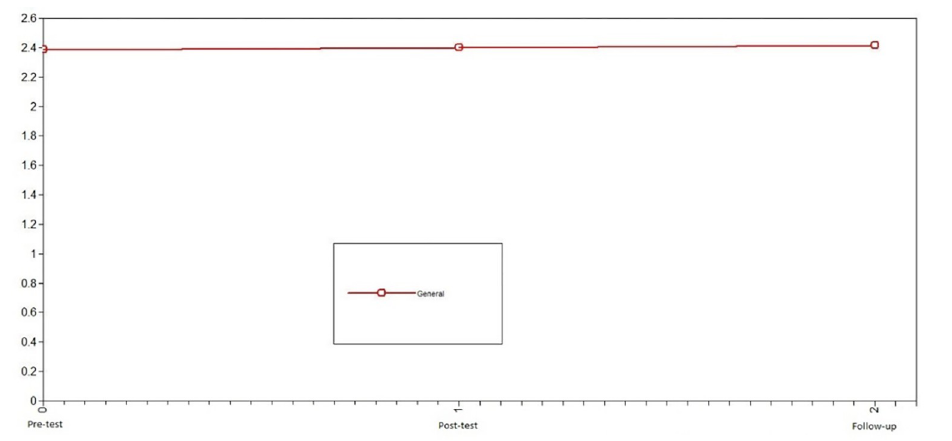
Fig 3. Latent growth curve models of positive emotions of the intervention group. The model that presented the best fit was the nonlinear change model.